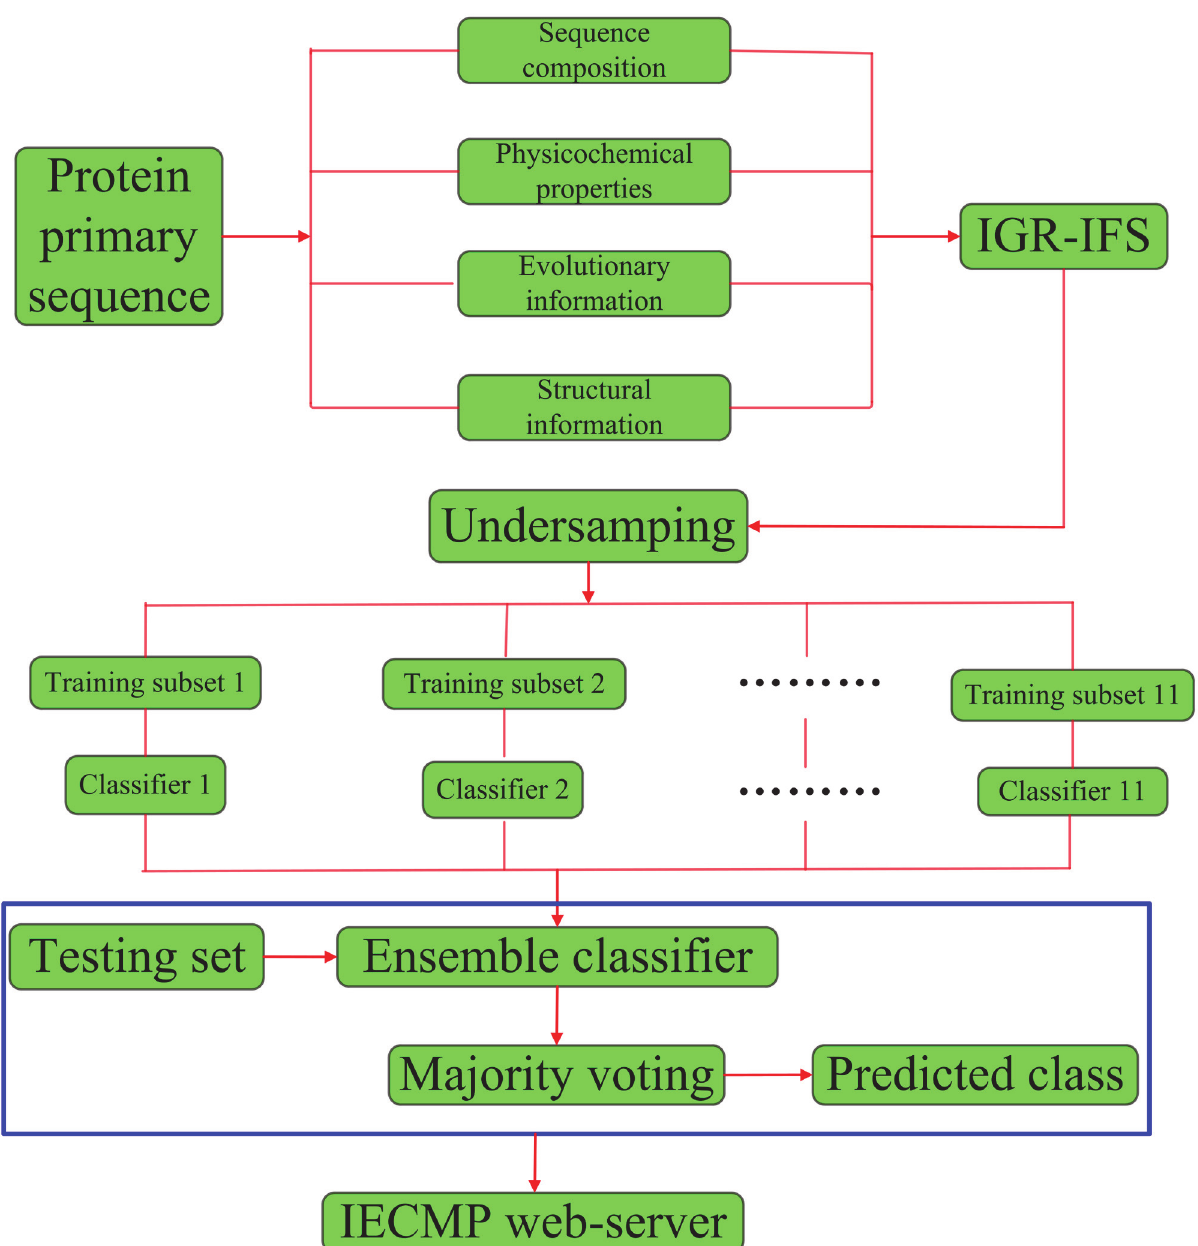
Fig 1. The overall work flow of the proposed method IECMP(Identify ECM Proteins). (i) The training sequences are mapped into feature vectors. (ii) To reduce the complexity and the feature redundancy, the Information Gain Ratio and Incremental Feature Selection (IGR-IFS) methods are employed. (iii) The training set is divided into 11 training subsets through the undersampling approach. (iv) With the optimal features, the 11 training subsets train Random Forest classifiers, respectively. (v) The predicted class labels of the test set are determined by the majority voting